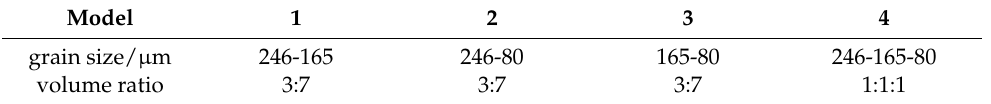
Table 4. Particle size distribution of propellants at different gradations.